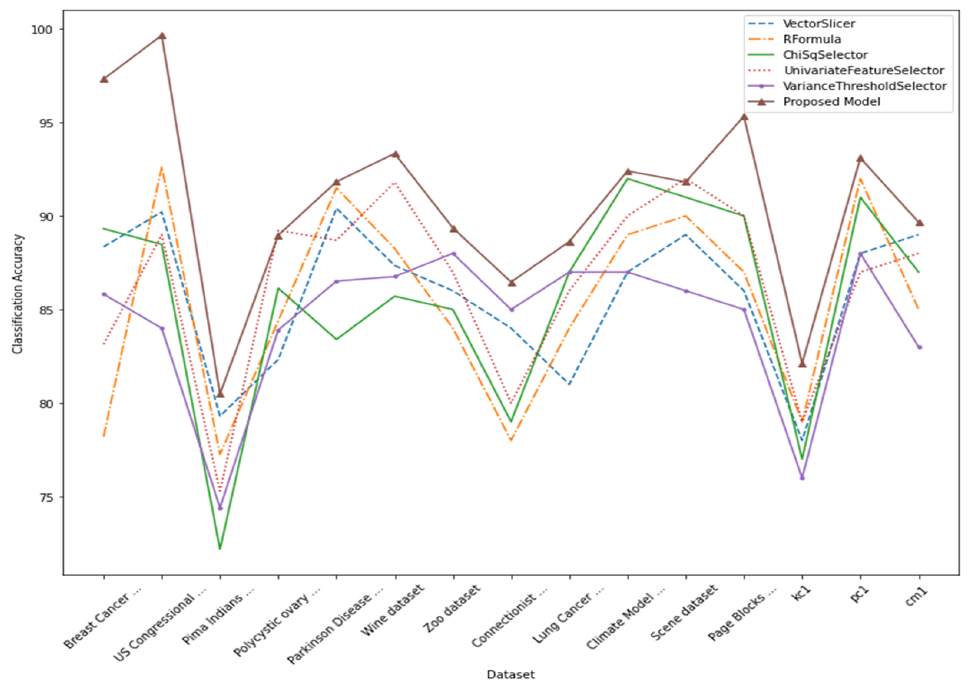
Figure 6. Comparison of classification accuracies of proposed model with state-of-the-art feature selection algorithms.